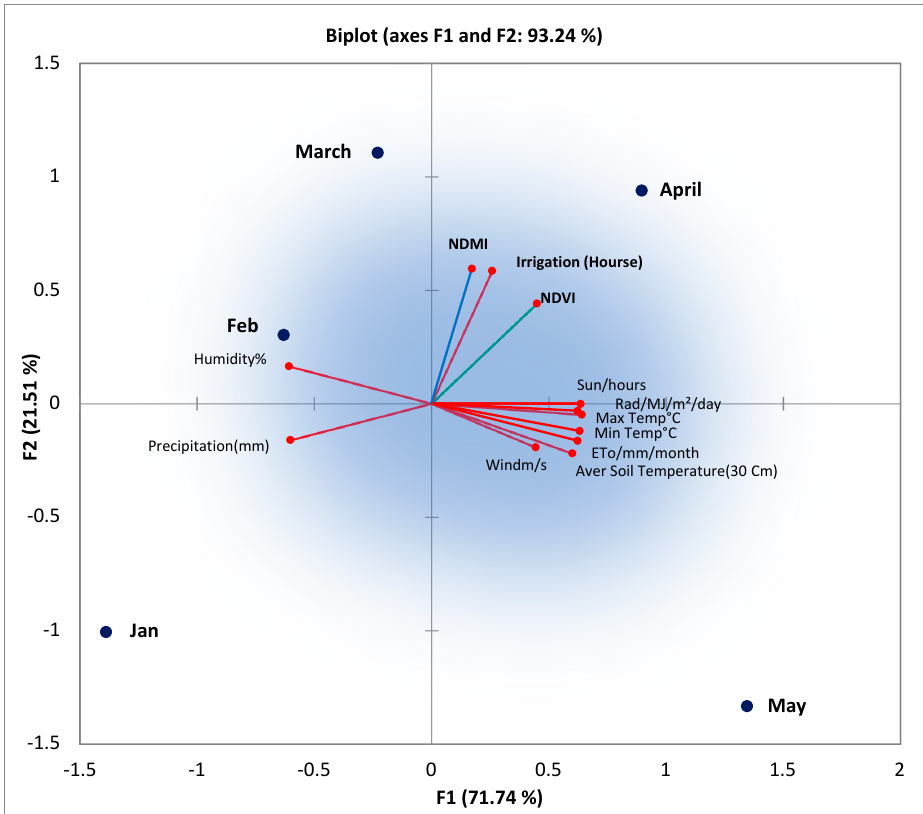
Figure 14. Principal Component Analysis of temporal Pattern changes of NDVI and NDMI with Meteorological parameters.